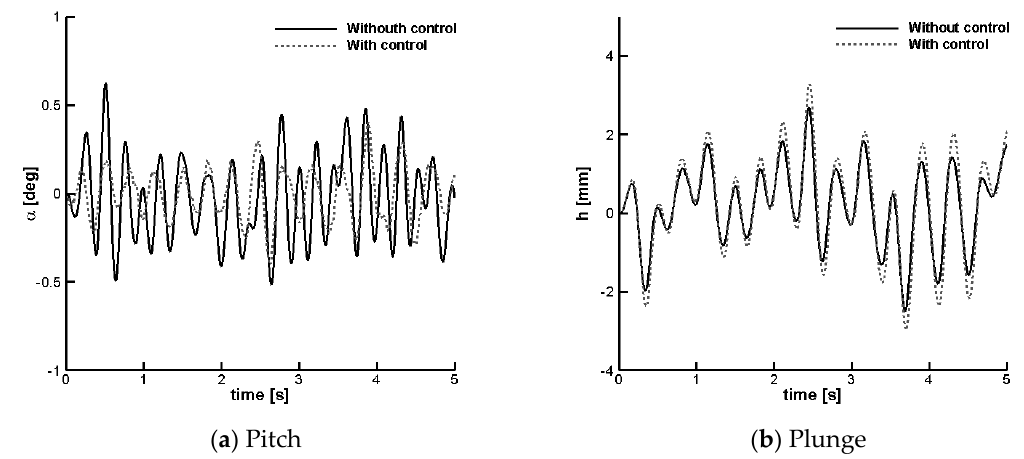
Figure 13. Aeroelastic response due to a random atmospheric turbulence (Figure 12) with and without control.